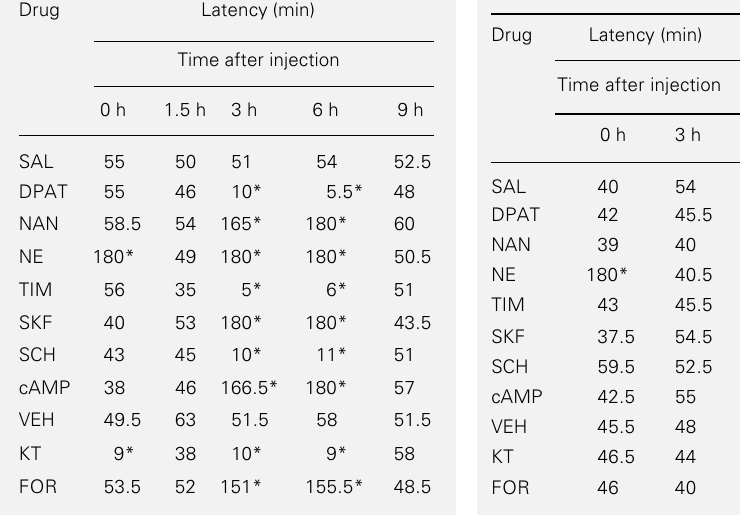
Table 1 - Median test session latency in groups infused bilaterally into the hippocampus with the following drugs: 8-OH-DPAT (DPAT), NAN-190 (NAN), norepinephrine (NE), timolol (TIM), SKF38393 (SKF), SCH23390 (SCH), 8-Br-cAMP (cAMP), KT5720 (KT), forskolin (FOR), vehicle (VEH) and saline (SAL).